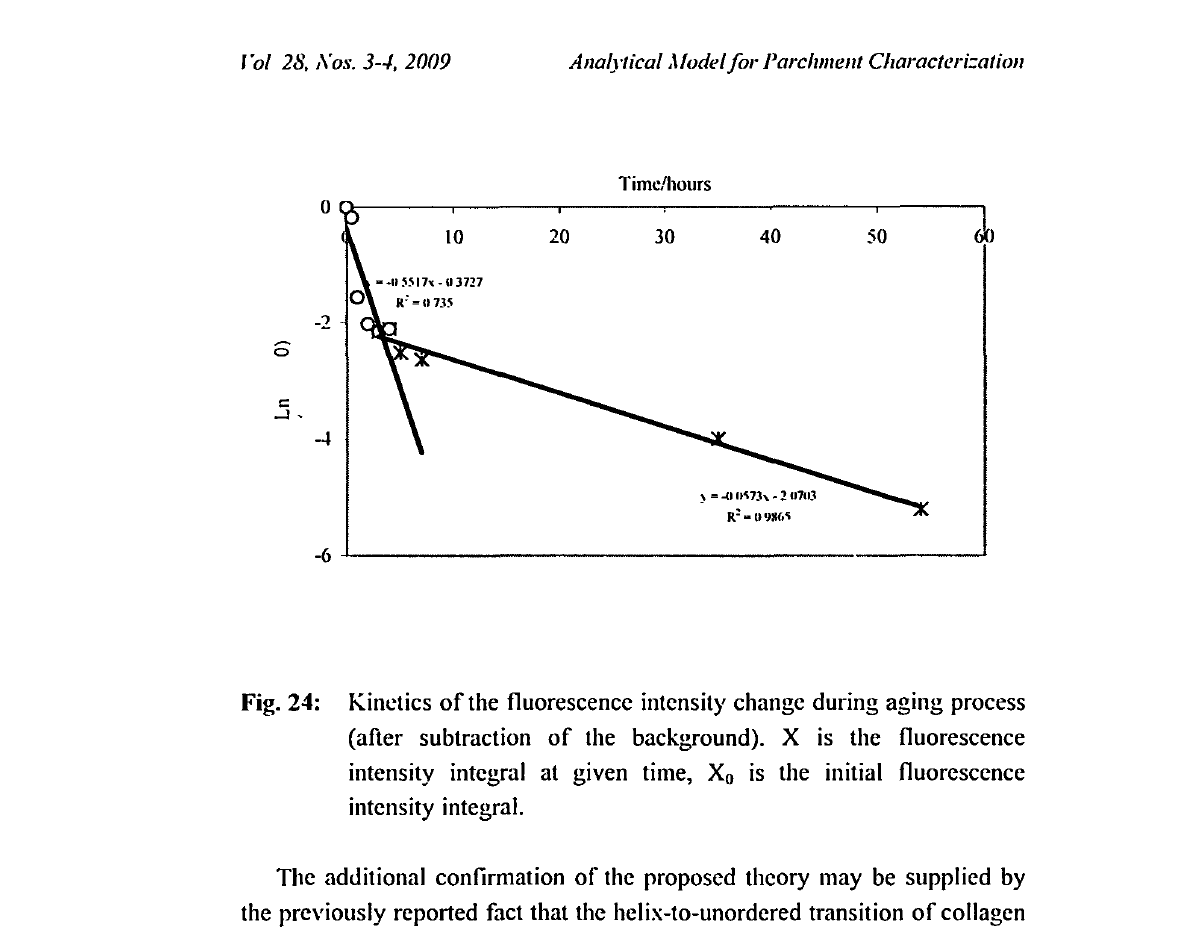
Fig. 24: Kinetics of the fluorescence intensity change during aging process (after subtraction of the background). X is the fluorescence intensity integral at given time, X is the initial fluorescence 0 intensity